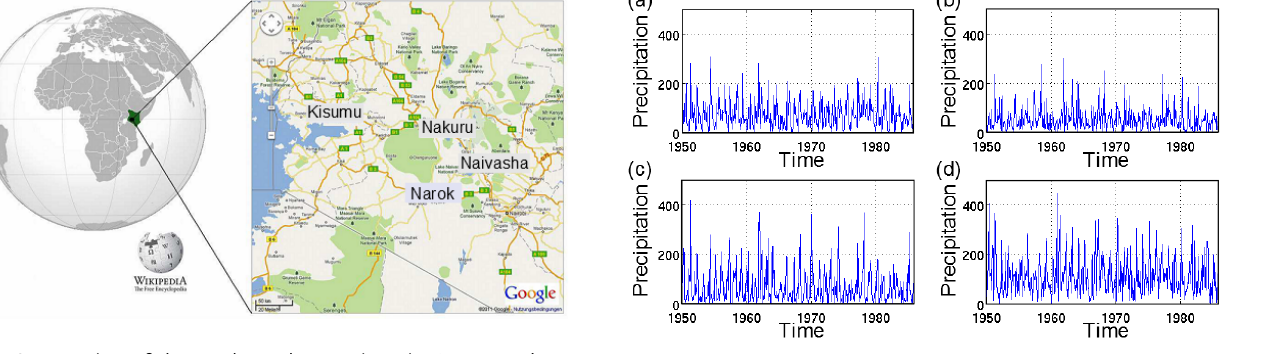
cult to reliably estimate parameters and distributions for short observations.